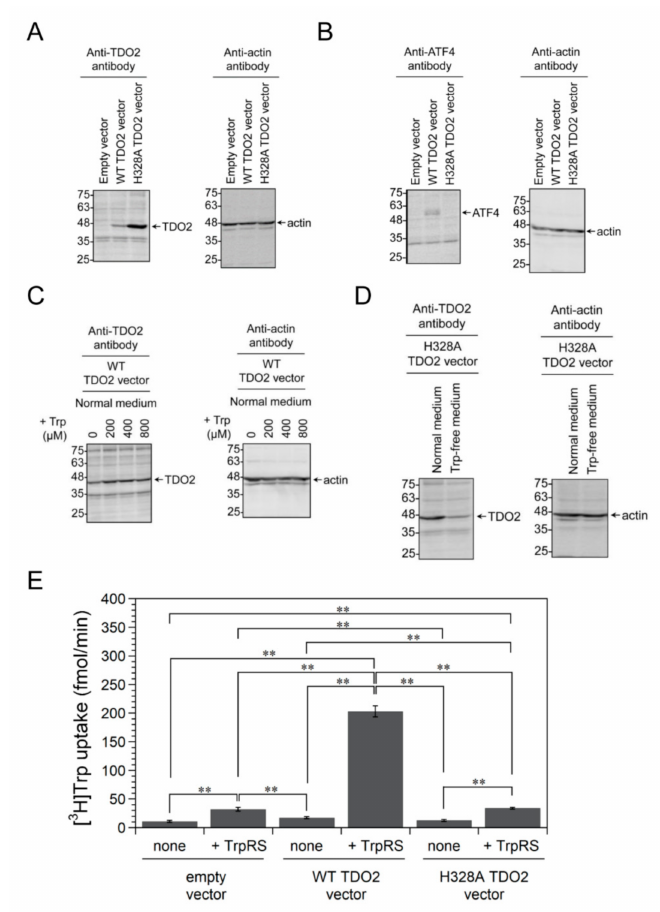
Figure 4. The e ff ect of adding human TrpRS protein to the assay bu ff er on [ 3 H]Trp uptake by HeLa cells overexpressing nontagged human tryptophan 2,3-dioxygenase (TDO2). Control vector, human WT TDO2 or H328A TDO2 mutant expression vector was transfected into HeLa cells. ( A ) Western blot analysis of extracts from nontagged human TDO2-overexpressing cells using anti-TDO2 or anti- β -actin antibodies. The arrows indicate the expected position of TDO2 or β -actin. Molecular size markers (kDa) are shown on the left. ( B ) Western blot analysis of extracts from nontagged human TDO2-overexpressing cells using anti-ATF4 or anti- β -actin antibodies. The arrows indicate the expected positions of ATF4 and β -actin. Molecular size markers (kDa) are shown on the left. ( C ) Western blot analyses of extracts of nontagged human WT TDO2-overexpressing HeLa cells, which were incubated in normal medium with additional Trp (0, 200, 400, or 800 µ M Trp) for 18 h, by using anti-TDO2 or anti- β -actin antibodies. Final concentration of Trp in the medium is 80, 280, 480, or 880 µ M, because normal medium contains 80 µ M Trp. ( D ) Western blot analyses of extracts of nontagged human H328A TDO2 mutant-overexpressing HeLa cells, which were incubated in normal medium or in Trp-free medium for 24 h, by using anti-TDO2 or anti- β -actin antibodies. ( E ) [ 3 H]Trp uptake into HeLa cells, in which human WT TDO2 or H328A TDO2 mutant was overexpressed, in the absence or presence of human TrpRS protein. All data are expressed as means ± SD of four independent experiments. ** p <